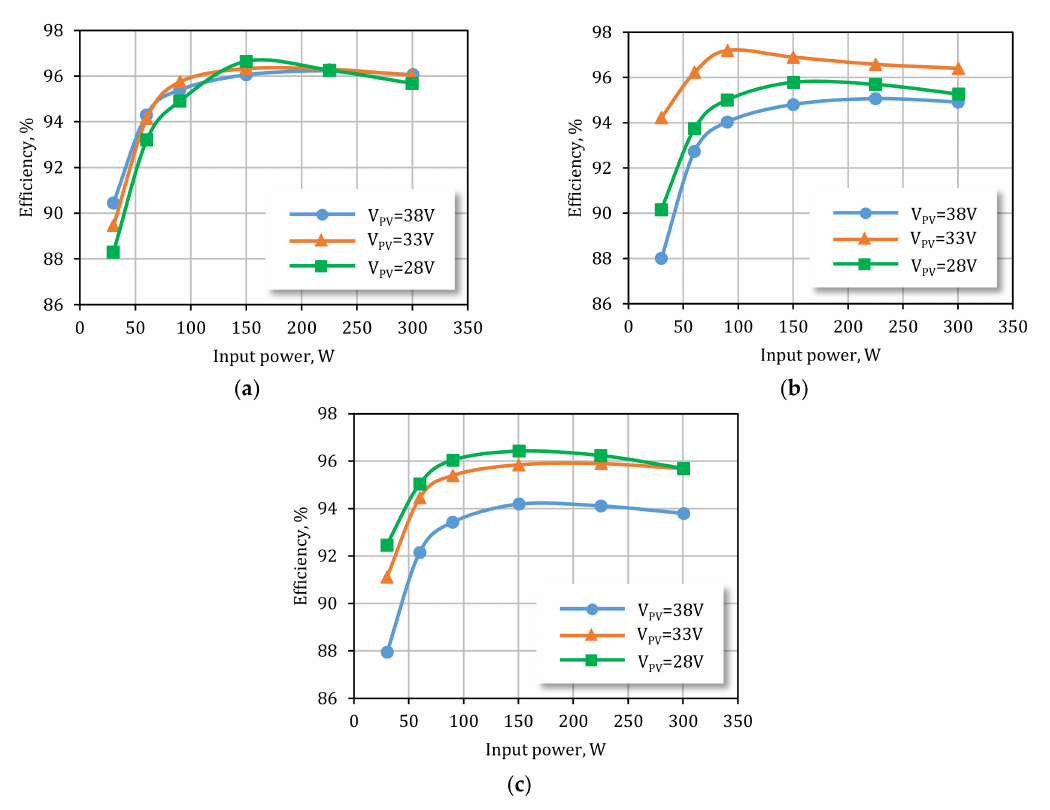
Figure 10. Comparison of measured e ffi ciency of the converter for the turns ratio of: ( a ) n 1 = 5.7, ( b ) n = 6.1, and ( c ) n 2 =